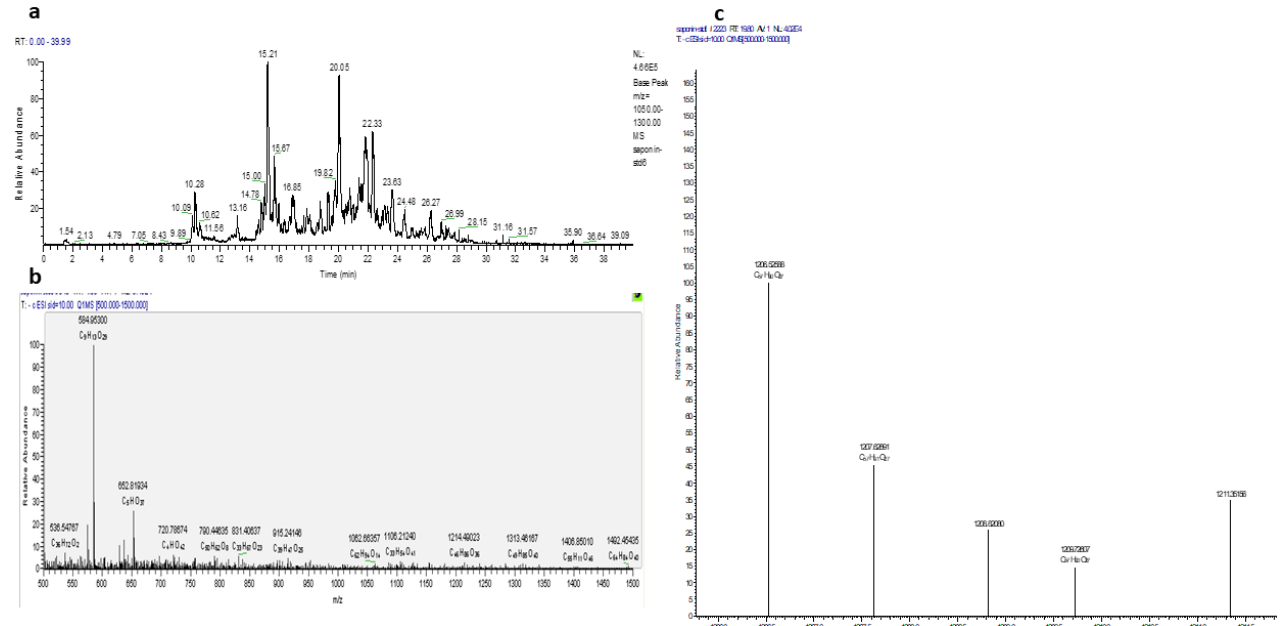
Figure 1. LC-MS-TOF analysis of the green tea seed extracted saponin. ( a ). LC-MS chromatogram of various saponins extracted from green tea seeds via HPLC ( b ) and the purified fraction containing the pure, isolated theasaponin E1 ( c ) The base peak intensity mass spectrum of green tea seed extracted saponins.